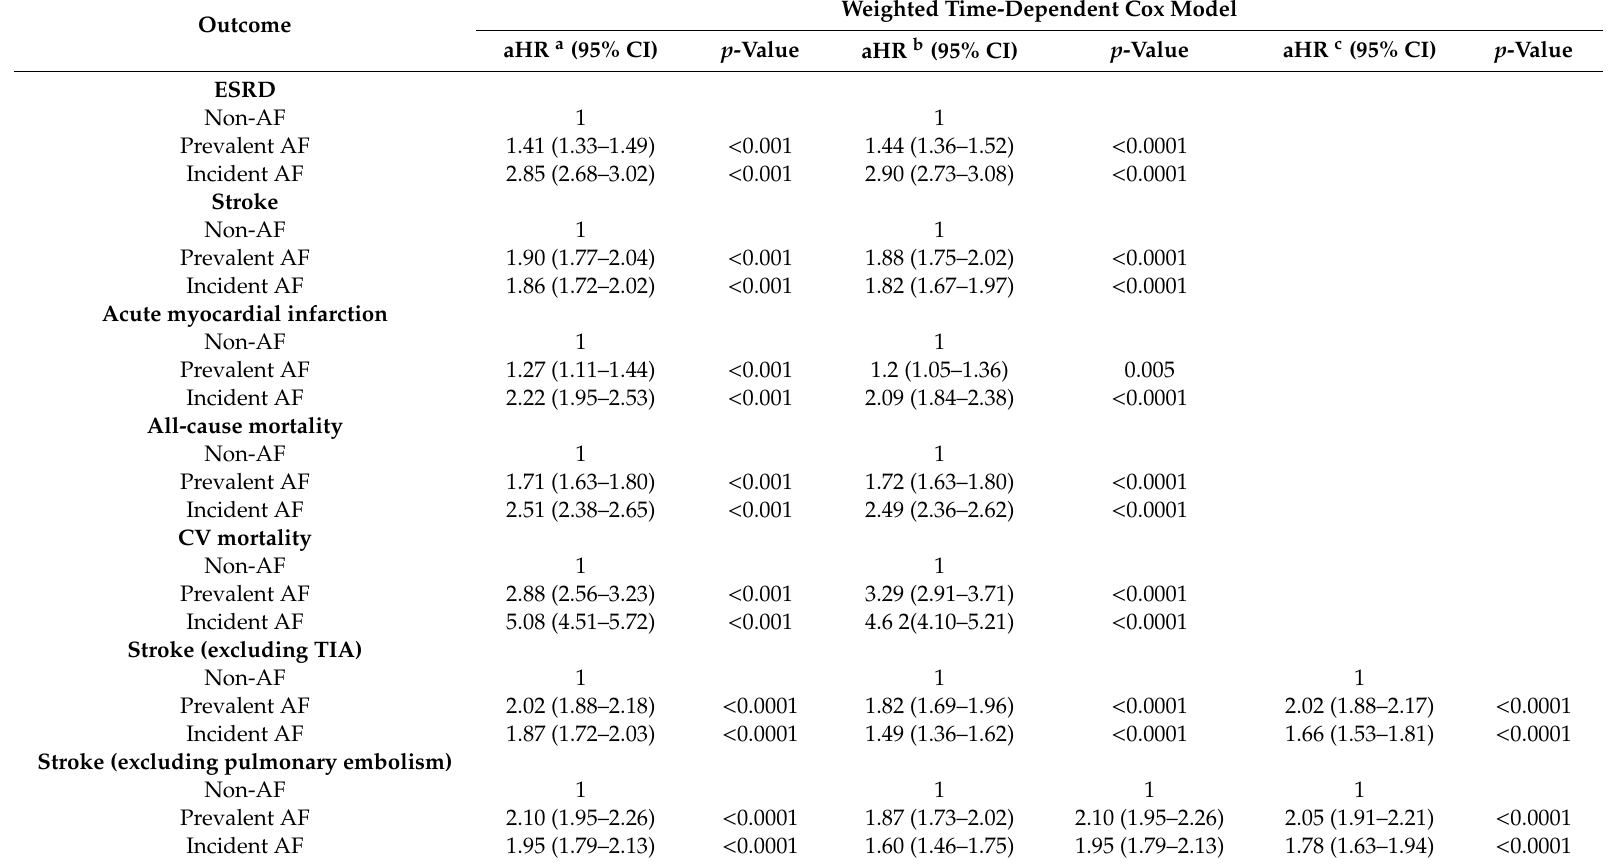
Table 4. Sensitivity